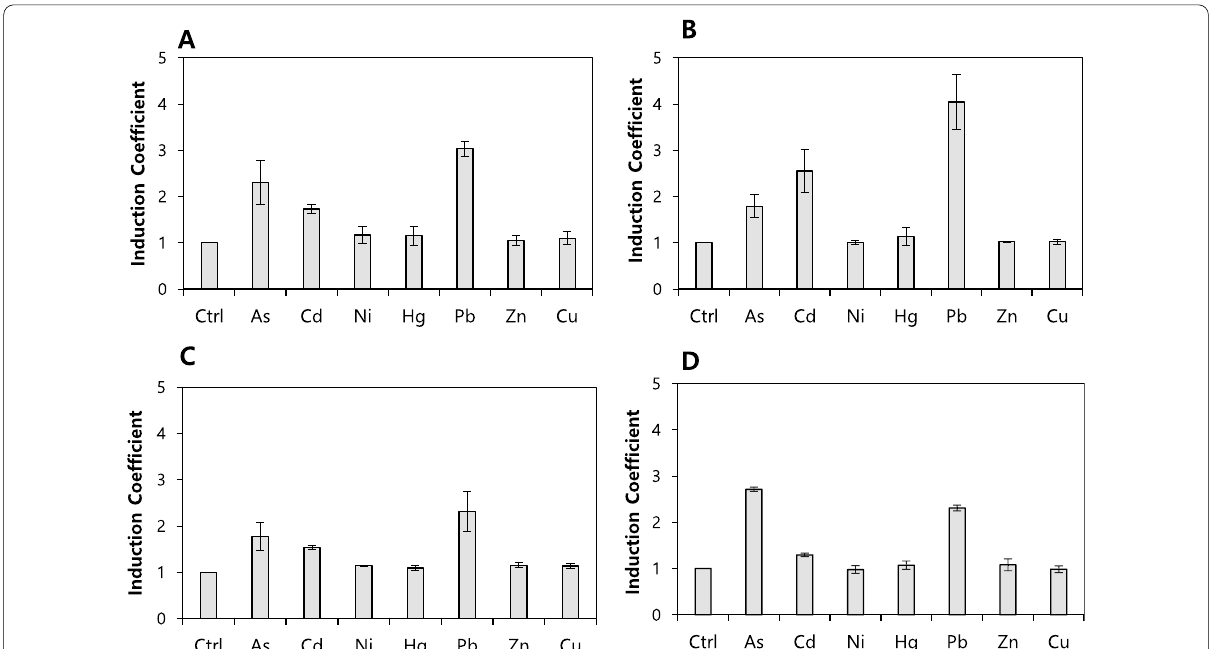
Fig. 3 Metal selectivity of biosensors based on E. coli-arsR/zntA upon engineered ArsRs. E. coli-arsR/zntA harboring pArsAp-eGFP and engineered ArsRs including ArsR W4 ( A ), ArsR W6 ( B ), ArsR YJ6 ( C ), and ArsR YJ20 ( D ) exposed to 5 µM of metal(loid) ions for 2